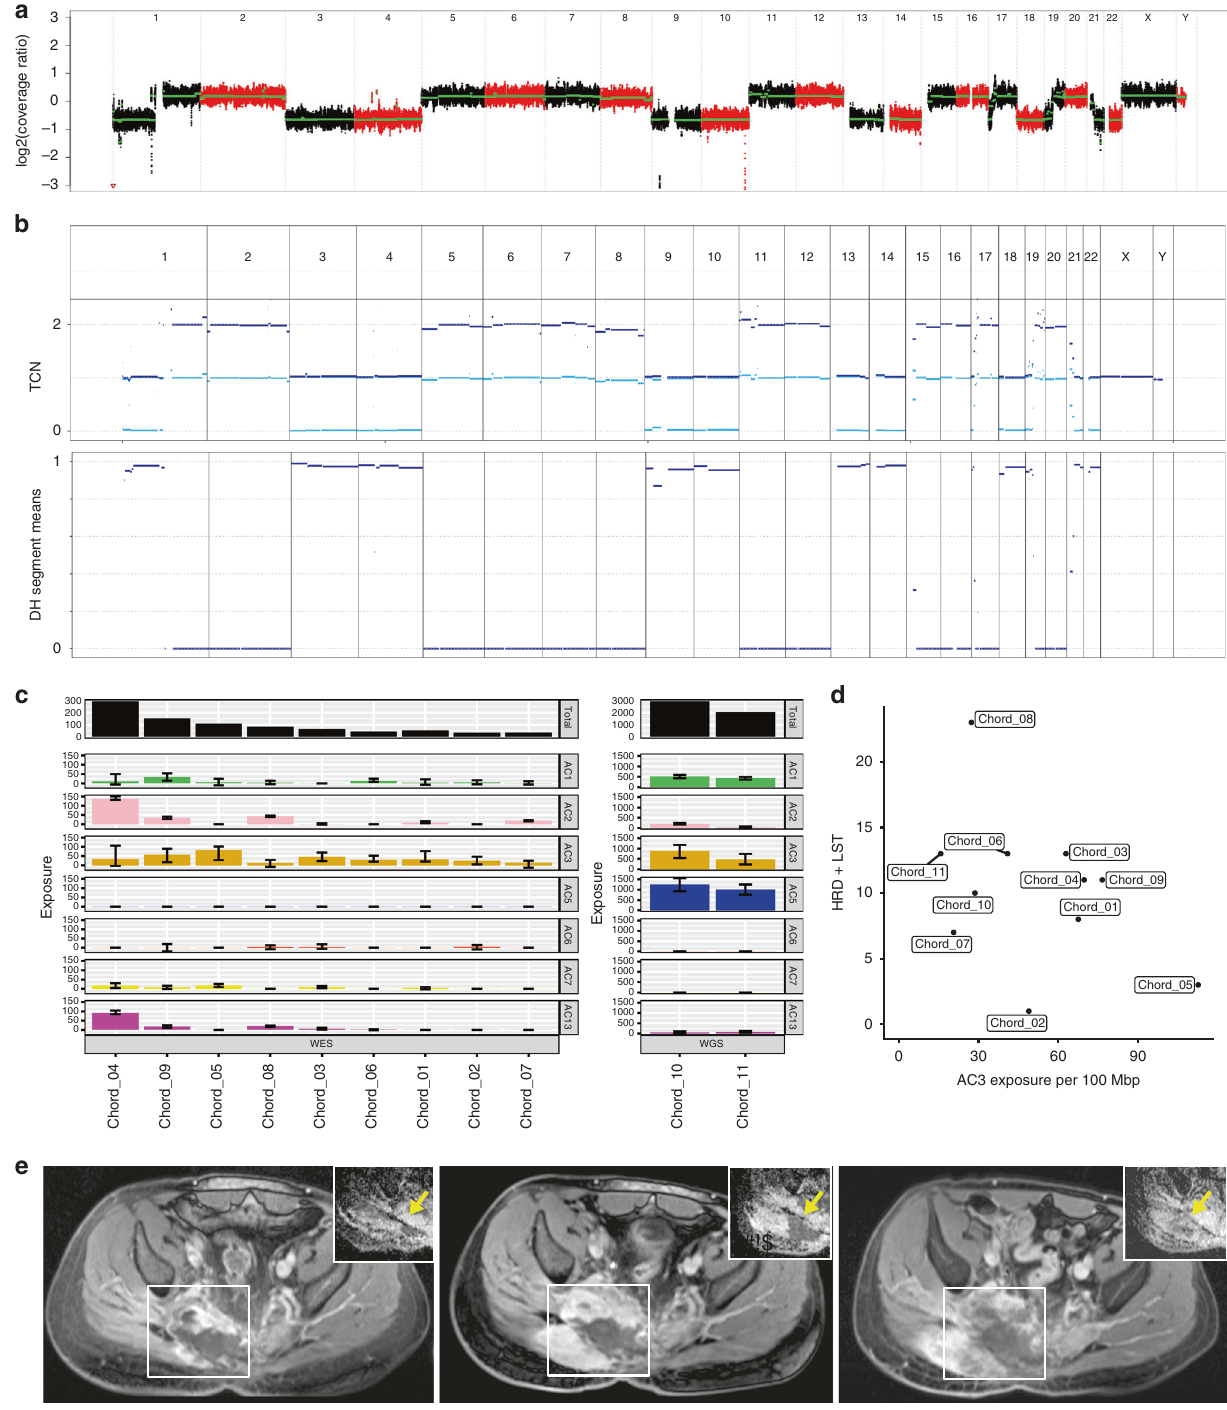
the exposure to AC3 excluded zero in eight of 11 samples (72.7%; Fig. 1c). Comparison of the signatures identi fi ed in our cohort to a background of 7042 cancer samples (WGS, n = 507; WES, n = 6,535) 17 showed signi fi cant enrichment of AC3 ( P = 4.52 × 10 – 6 ). Signature AC3 co-occurred with extensive genomic instability, as illustrated by HR de fi ciency (HRD) scores and high numbers of large-scale state transitions (LSTs; Fig. 1d) 18 . Actionability of defective HR DNA repair in chordoma . Patient Chord_05, while not meeting traditional criteria for defective HR NATURE COMMUNICATIONS| (2019) 10:1635 |https://doi.org/10.1038/s41467-019-09633-9|www.nature.com/naturecommunications